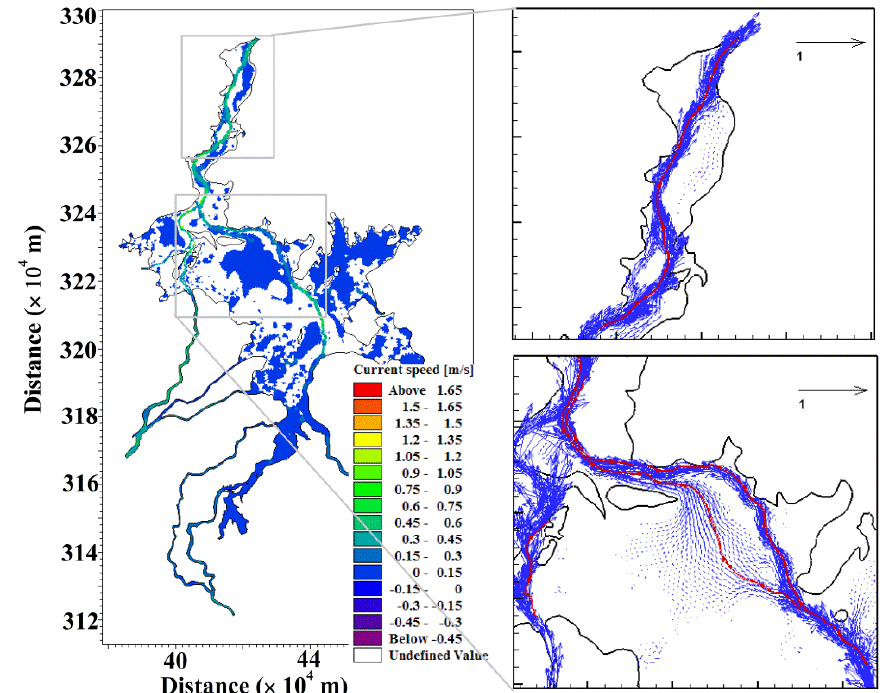
Figure 13. Map of the depth-averaged velocity (m/s) averaged over the low water level period of MIKE 21 runs and a close-up of the velocity field for the region of interest. Red arrows represent the streamlines and associated flow directions. Note that the “Undefined Value” represents dry